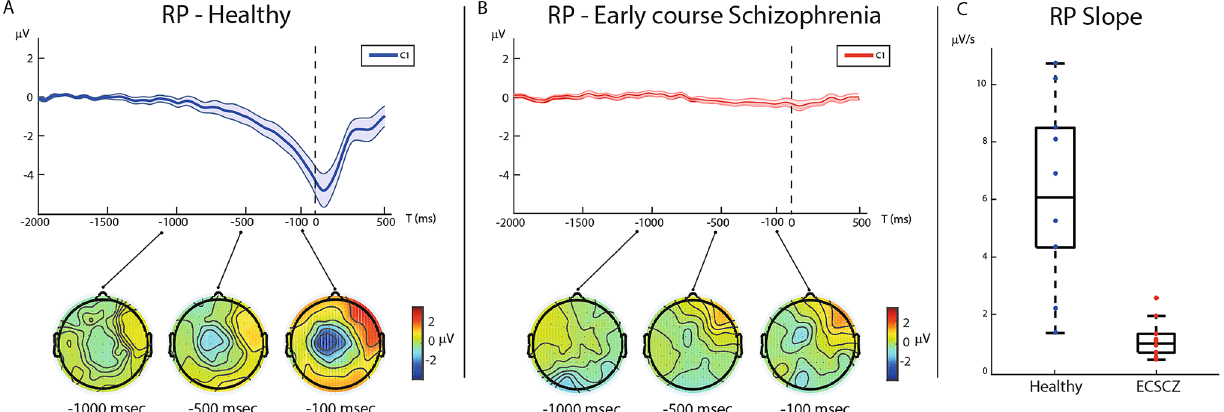
Figure 1. The Readiness Potential (RP) is greatly reduced in early-course Schizophrenia (ECSCZ). Time course of grand averages of electroencephalographic (EEG) trials at C1 electrode is shown for healthy subjects ( A , blue line) and ECSCZ patients ( B , red line). Standard errors of the mean are visualized in shaded colors. Topographic plots show scalp activity at − 1000 ms, − 500 ms, and − 100 ms. Box-plot with scatter points shows little overlap in RP slope between groups ( p = 0.004, Wilcoxon rank-sum test), corresponding to a large effect size (Cohen’s d = 2.18).